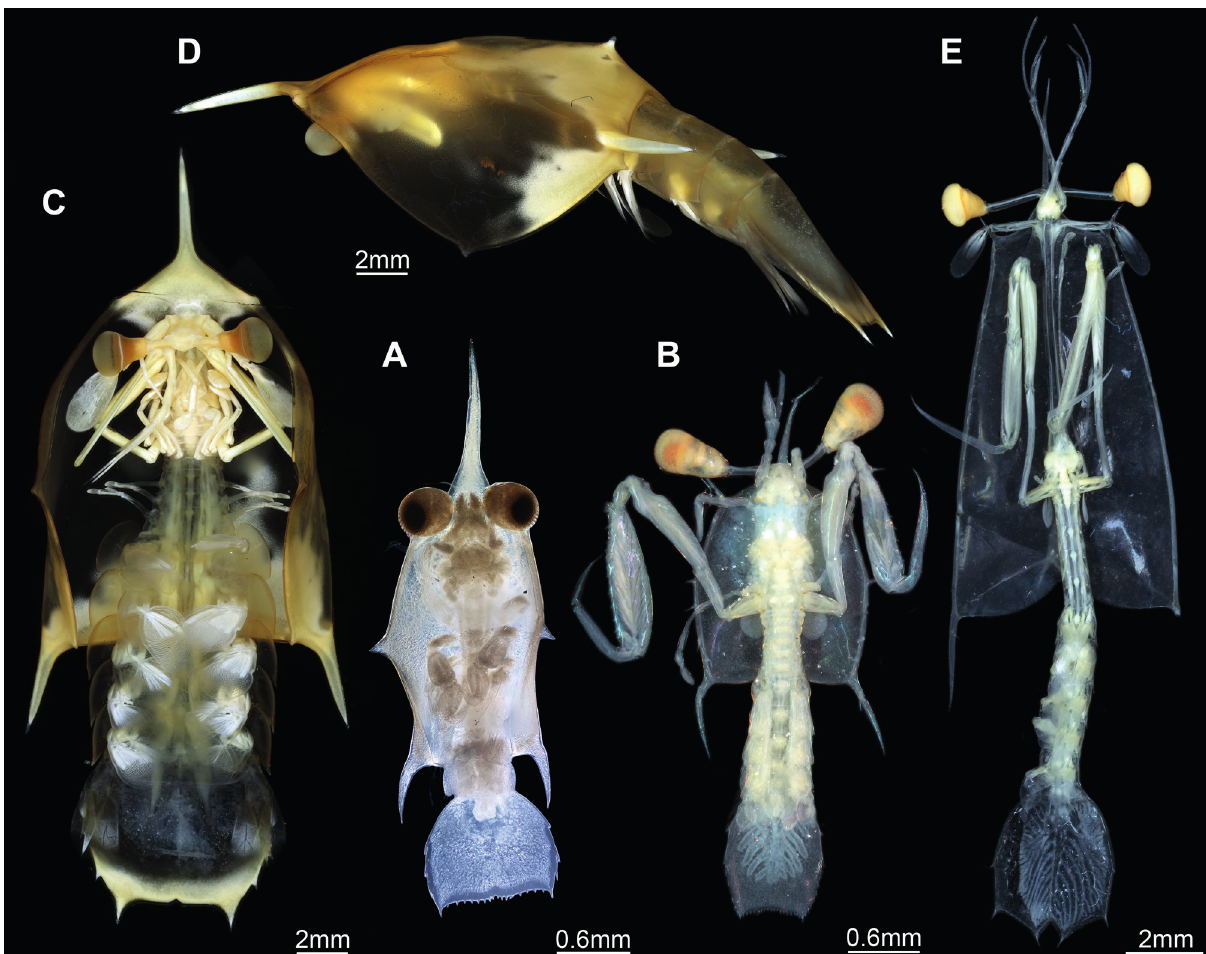
Figure 1. The four common types of mantis shrimp larvae. A. Antizoea, late form; ZMUC-CRU-8654. B. Pseudozoea; ZMUC- CRU-8659. C, D. Erichthus; ZMUC-CRU-8660. E. Alima, flipped horizontally; ZMUC-CRU-8655. A–C, E. Ventral view. D. Lateral view. A. Transmitted light. B–E. Reflected